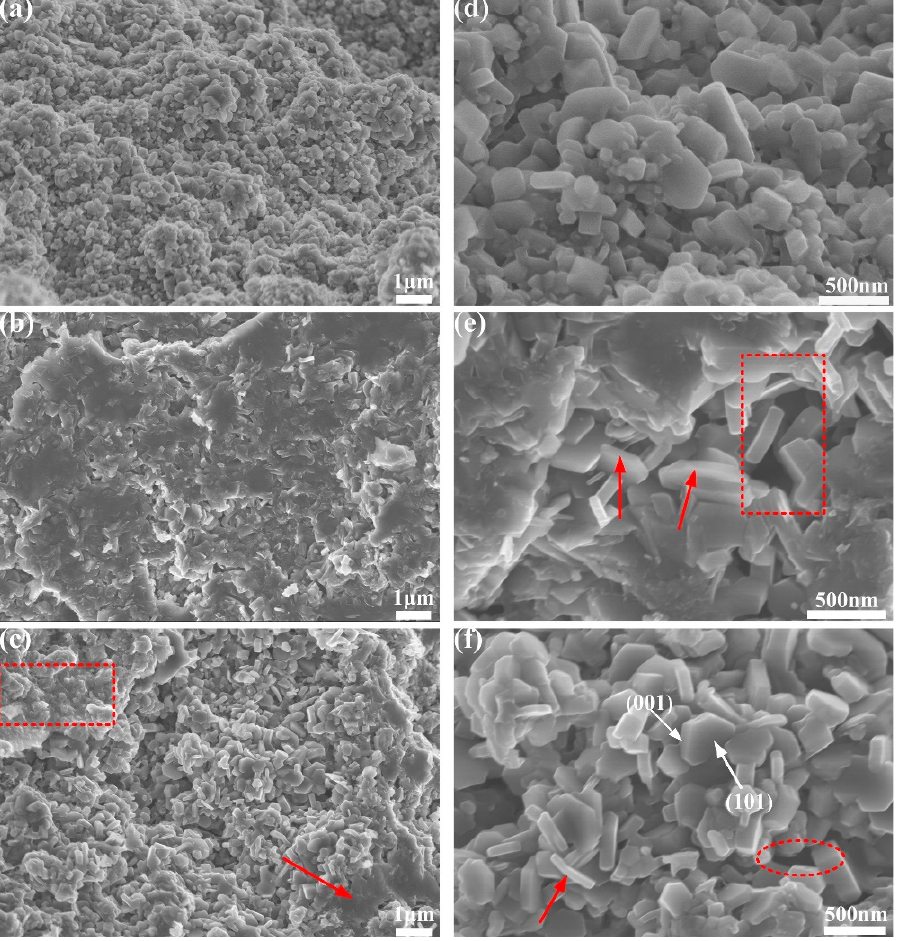
Figure 6. SEM images of doped 3D-CNS samples at low ( a – c ) and high magnification ( d – f ): ( a , d ) 3D-CNS0, ( b , e ) 3D-CNS0.1, ( c , f ) 3D-CNS0.2.